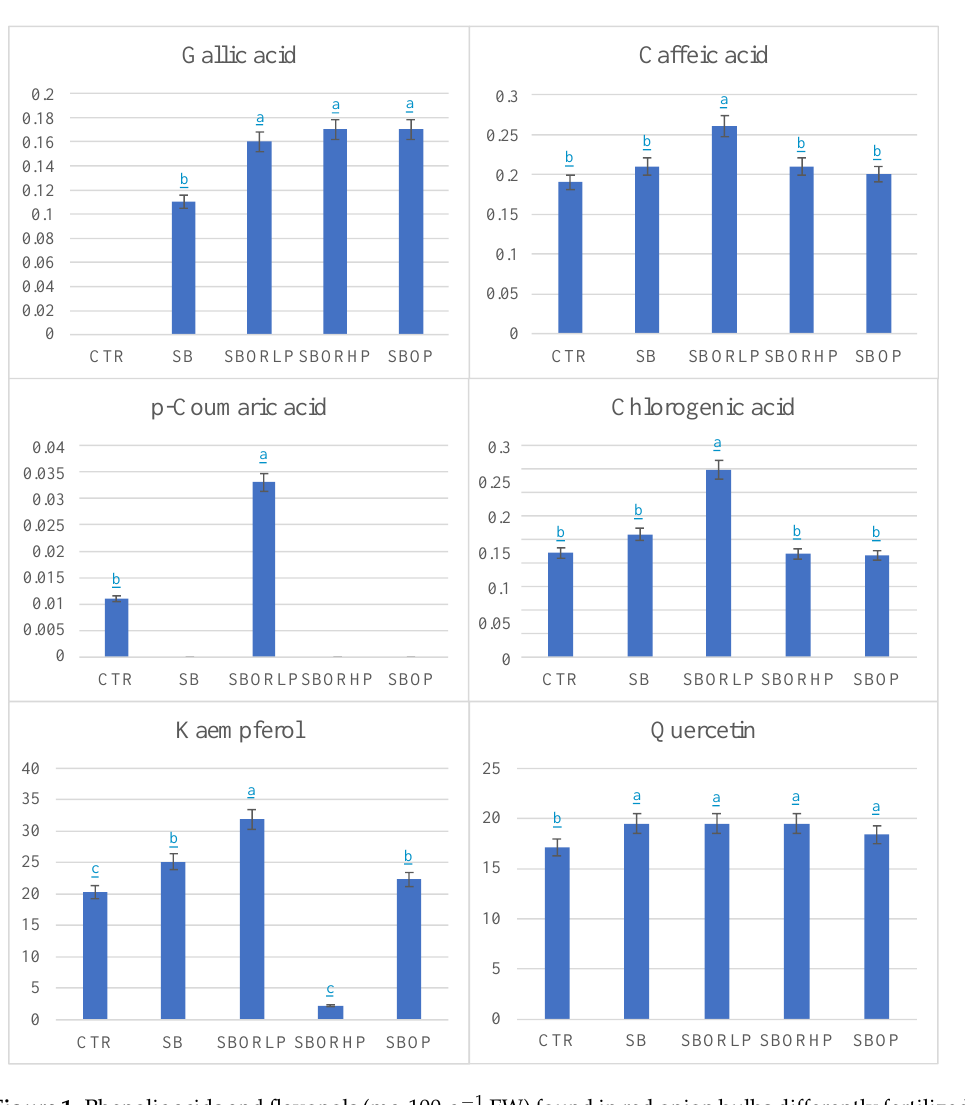
* Means followed by different letters in the same column are significantly different (Tukey’s test at